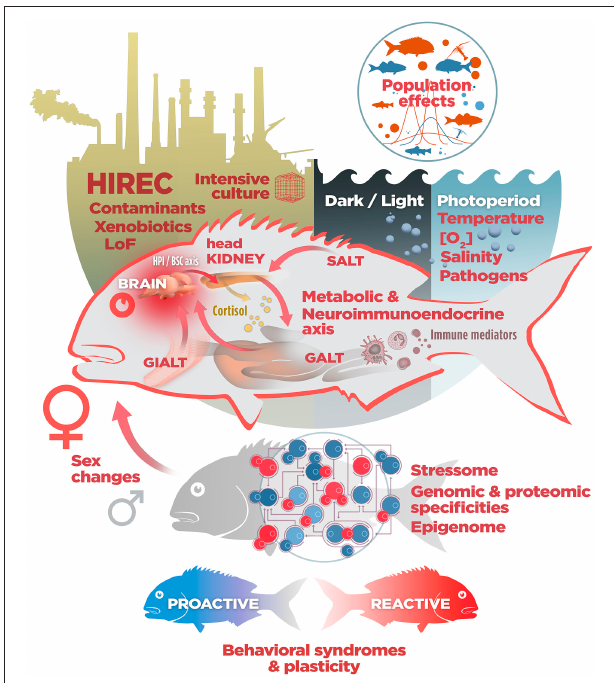
FIGURE 2 | A non-exhaustive list of stressotope components. In fish, the fate of stress responses to natural (temperature and oxygen variations, changes in salinity and photoperiod, abundance of pathogens in freshwater and marine realms...), artificial (cultured) and Human Induced Rapid Environmental Changes (HIREC) depends mainly, but not only, on environmental insults, perceived stressful scenarios influenced by continuous predation risk (Landscape of Fear, LoF) and species-specific intersex differential activation of stress, immune and metabolic axes. To what extent phenotypic plasticity helps to cope with maladaptive stressors in turn depends on evolutionary conserved life stories and behavioral repertoires (see the text for details and